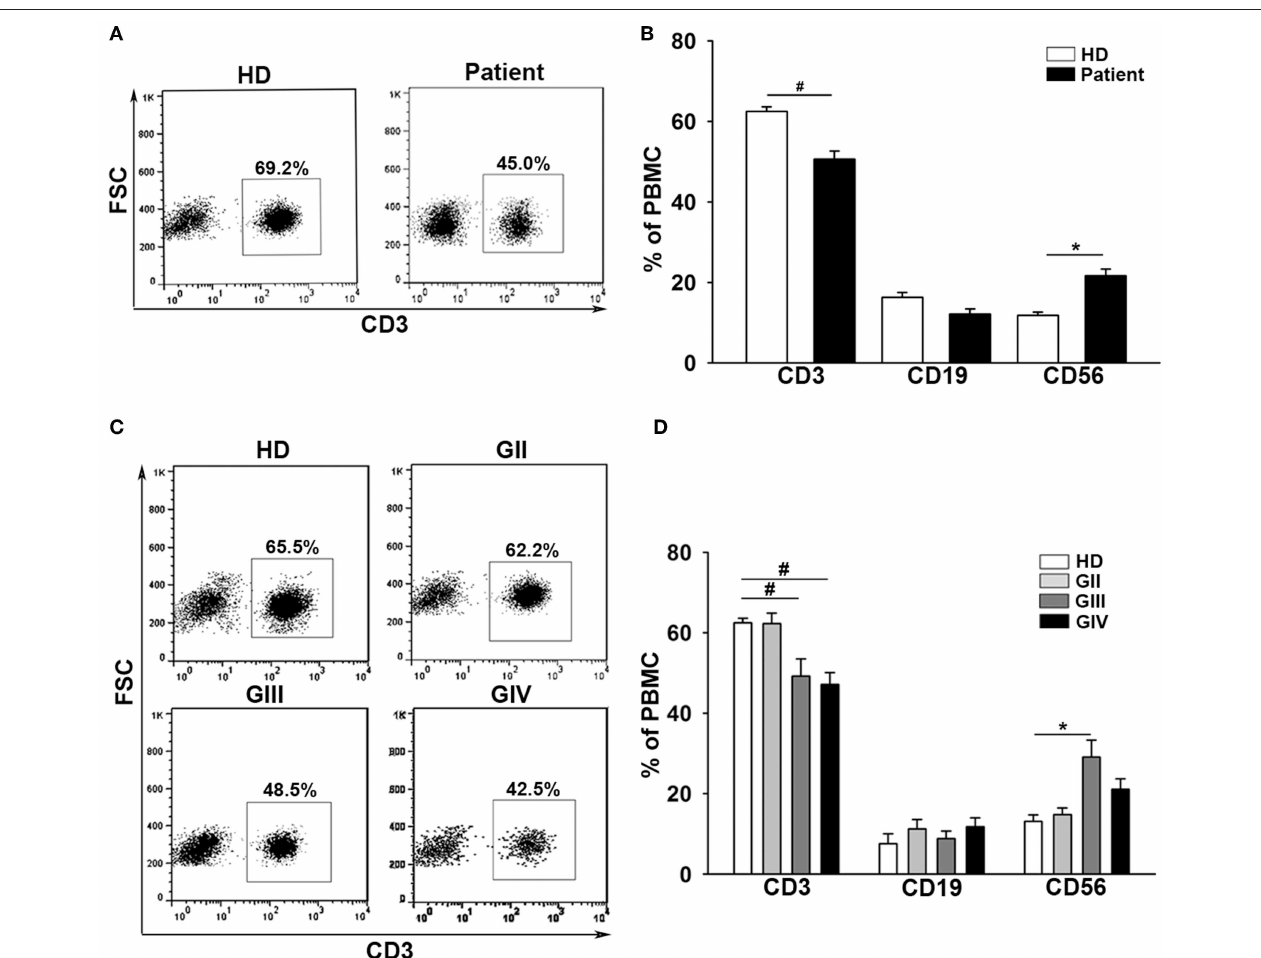
FIGURE 1 | Patients with glioma display a stepwise immune deficiency in accordance with the grade classification. (A) PBMCs from 31 healthy donors (HD) and 117 patients (Patient) were evaluated by flow cytometry for CD3, CD19, and CD56 after gating lymphocytes. (B) The percentages of CD3 + , CD19 + , and CD56 + cells were quantified. (C) The expression of CD3 + decreased in accordance with the grade. (D) Comparisons of the percentages of CD3 + , CD19 + , and CD56 + cells across the grades are shown. Values shown are means ± SEM (bars); * p < 0.05, # p < 0.01 by Student’s t-